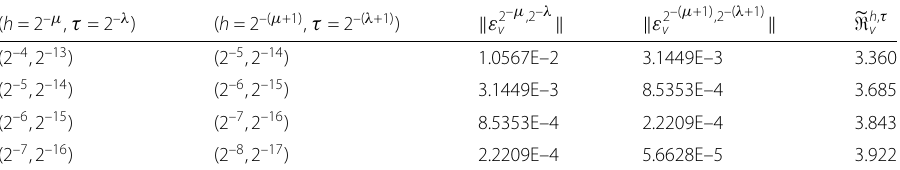
Table 3 Maximum errors and the order of convergence of approximate solution ˜ v with respect to h and τ for Example